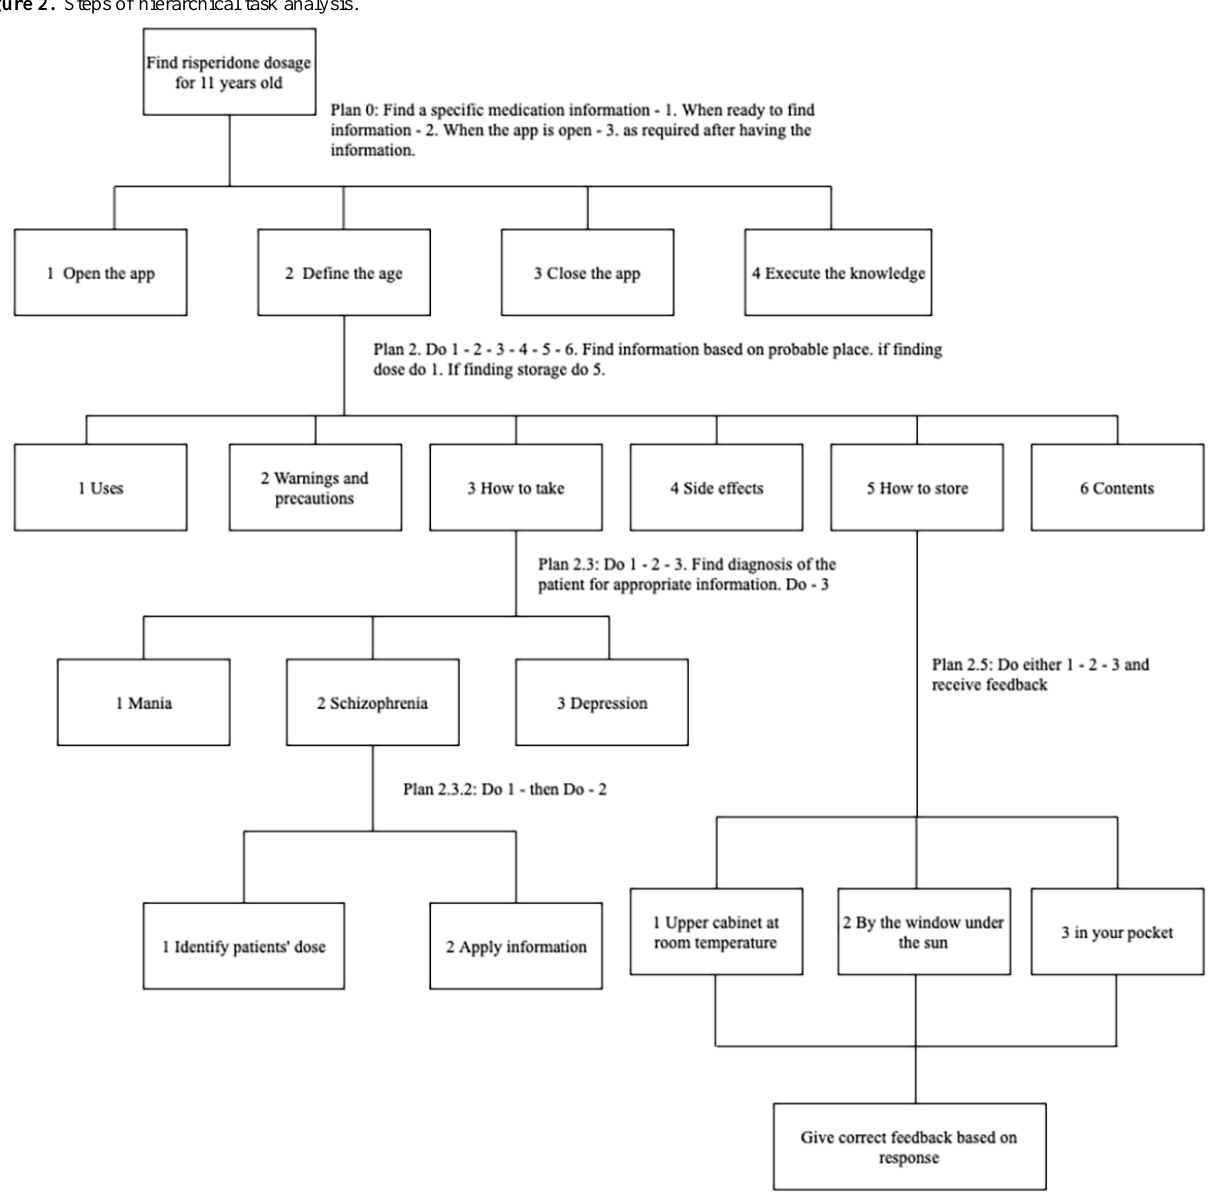
Figure 2. Steps of hierarchical task analysis.